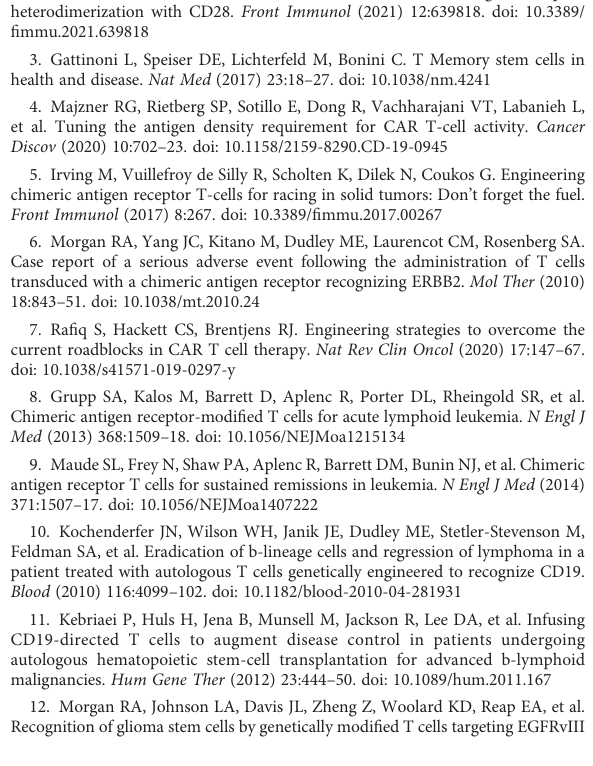
in Figure 2Btotest the activity andin fi ltration ofa lowernumber of Tcells) or saline. (C) Tumor weight at the end of the study. (D) Percentage of human CD3 + T cells and (E) CD3 + GFP + cells in fi ltrating tumors at the end of the study (normalized for tumor volume). (F) SKOV3 CMAH tumor growth curves over days upon peritumoral injections of 2x10 6 T cells or saline (independent repetition of B). (G) Tumor weight at the end of the study. Shown is average ± sem (B, F) , ± SD (C, G) or box and whiskers (min to max) (D) . Statistical analysis by two-way ANOVA (B, F) and unpaired